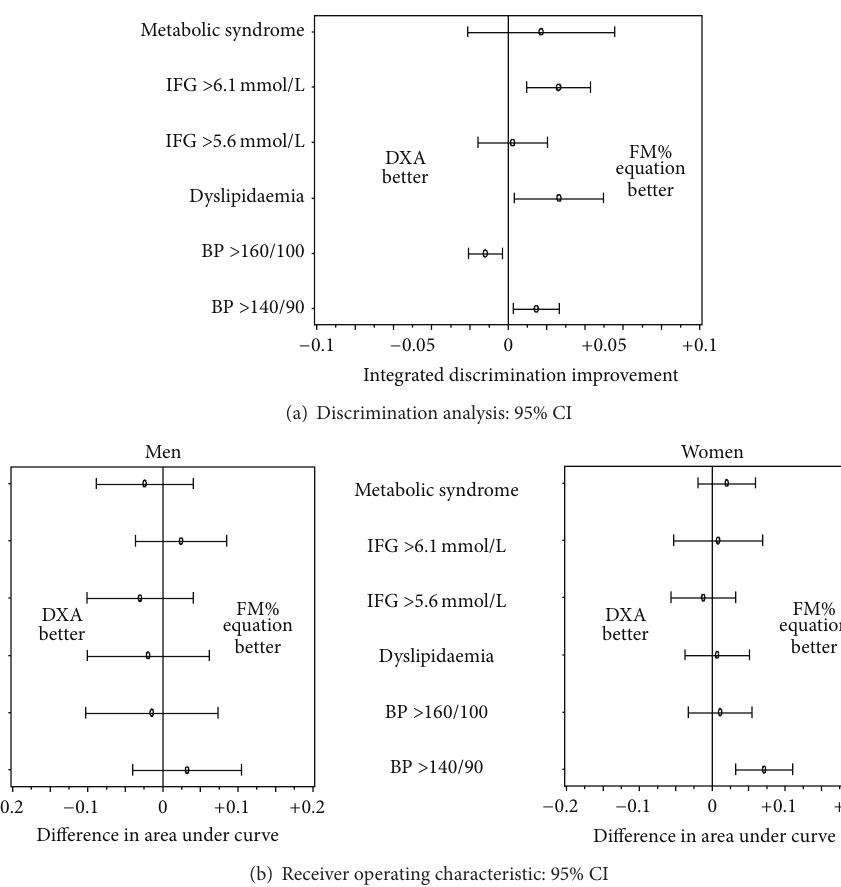
Figure 5: Comparison of DXA and anthropometry-based estimate of fat mass percent (FM% equation) as predictors of cardiometabolic risk factors. (a) Comparison of the integrated discrimination (= mean individual prediction of cases − mean individual prediction of referents) between categories of obesity based on DXA measurements and categories-based on anthropometry-based estimate of fat mass percentage (FM% equation) basis: whole study population, both men and women. (b) Difference in area under curve between fat mass % as a continuous variable measured by DXA and estimated by